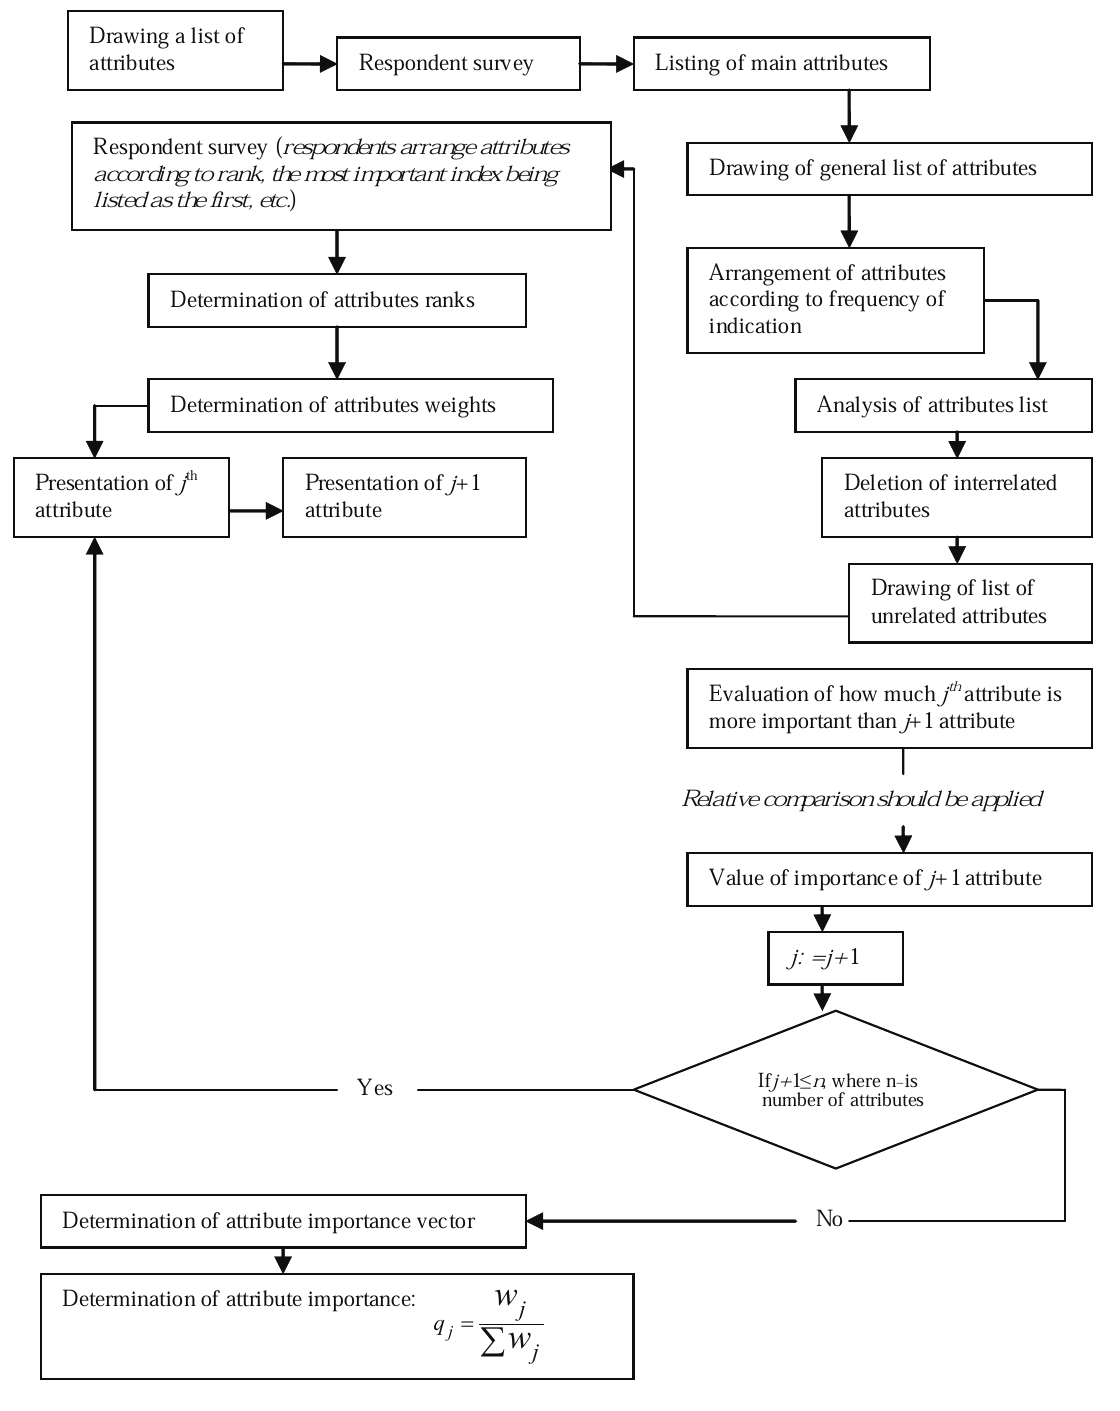
Fig. 2. Determining of the attribute